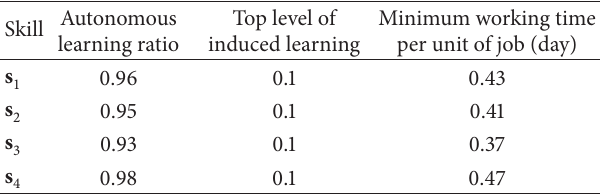
Table 1: Activities of example project.